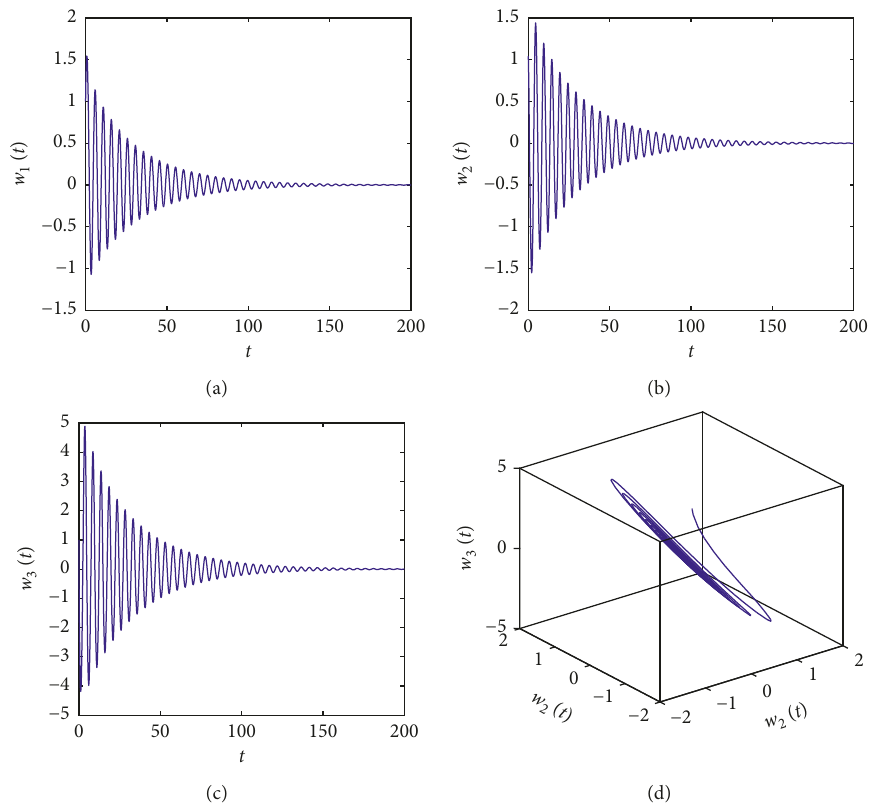
Figure 6: Computer simulations of model (70) when ρ